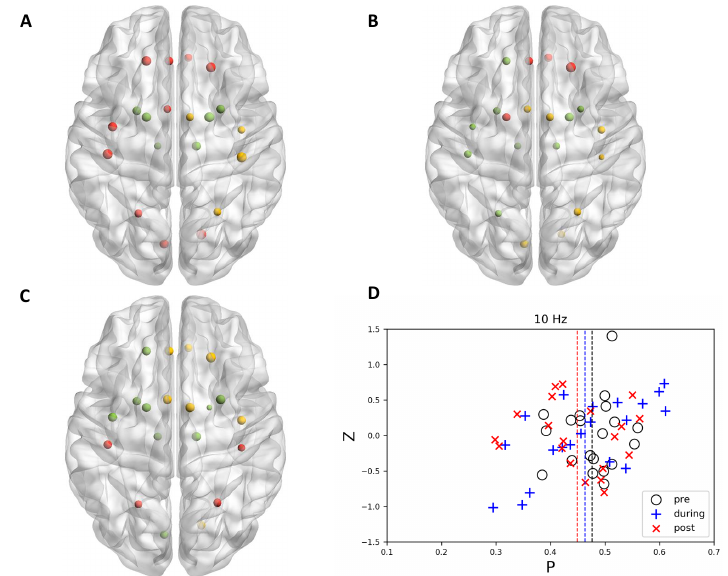
Figure 3. The node topology and community structure of 10 Hz stimulation in motor-related regions at ( A ) pre, ( B ) during, and ( C ) post time points. Left orientation represents left side of the brain. Panel ( D ) illustrated P - z plot for 10 Hz